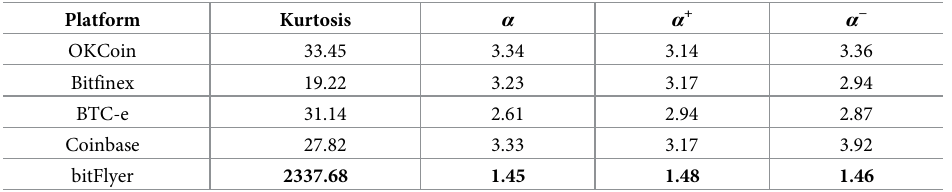
Table 2. The statistical information about normalized price return when Δ t = 2 min in different Bitcoin platforms.